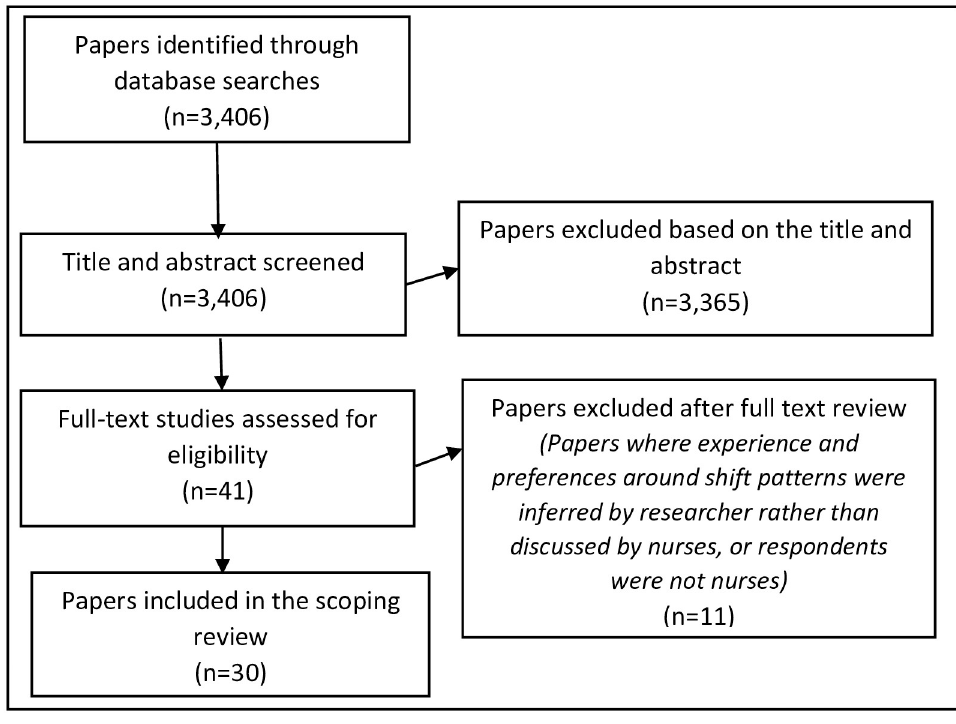
Fig 1. Prisma flow diagram of the literature search and screening process for the scoping review on nurses’ experience and preferences around shift patterns.